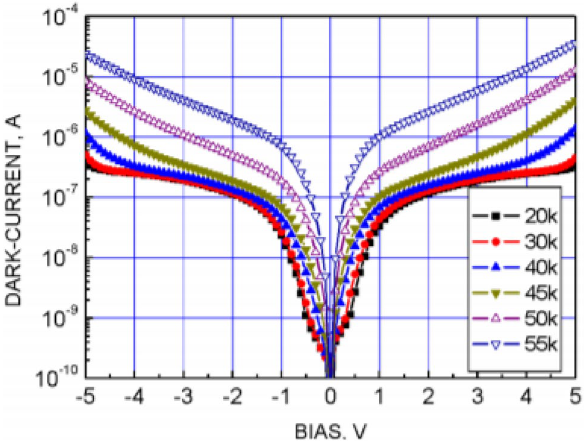
Figure 6. Relationship of dark current and operating temperature of QWIP 13 .